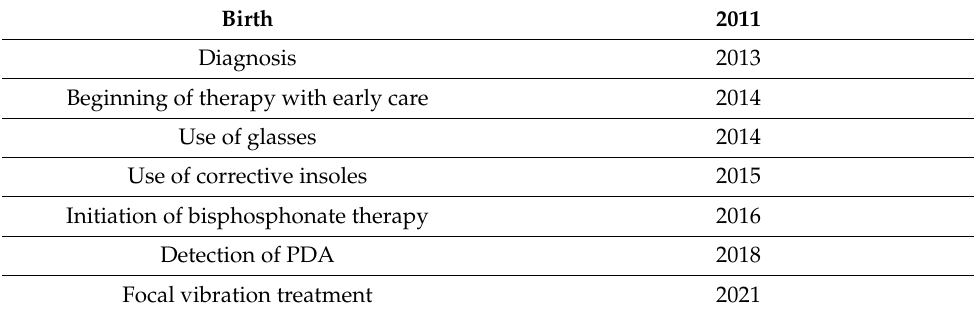
Table 3. Main milestones in the description of the